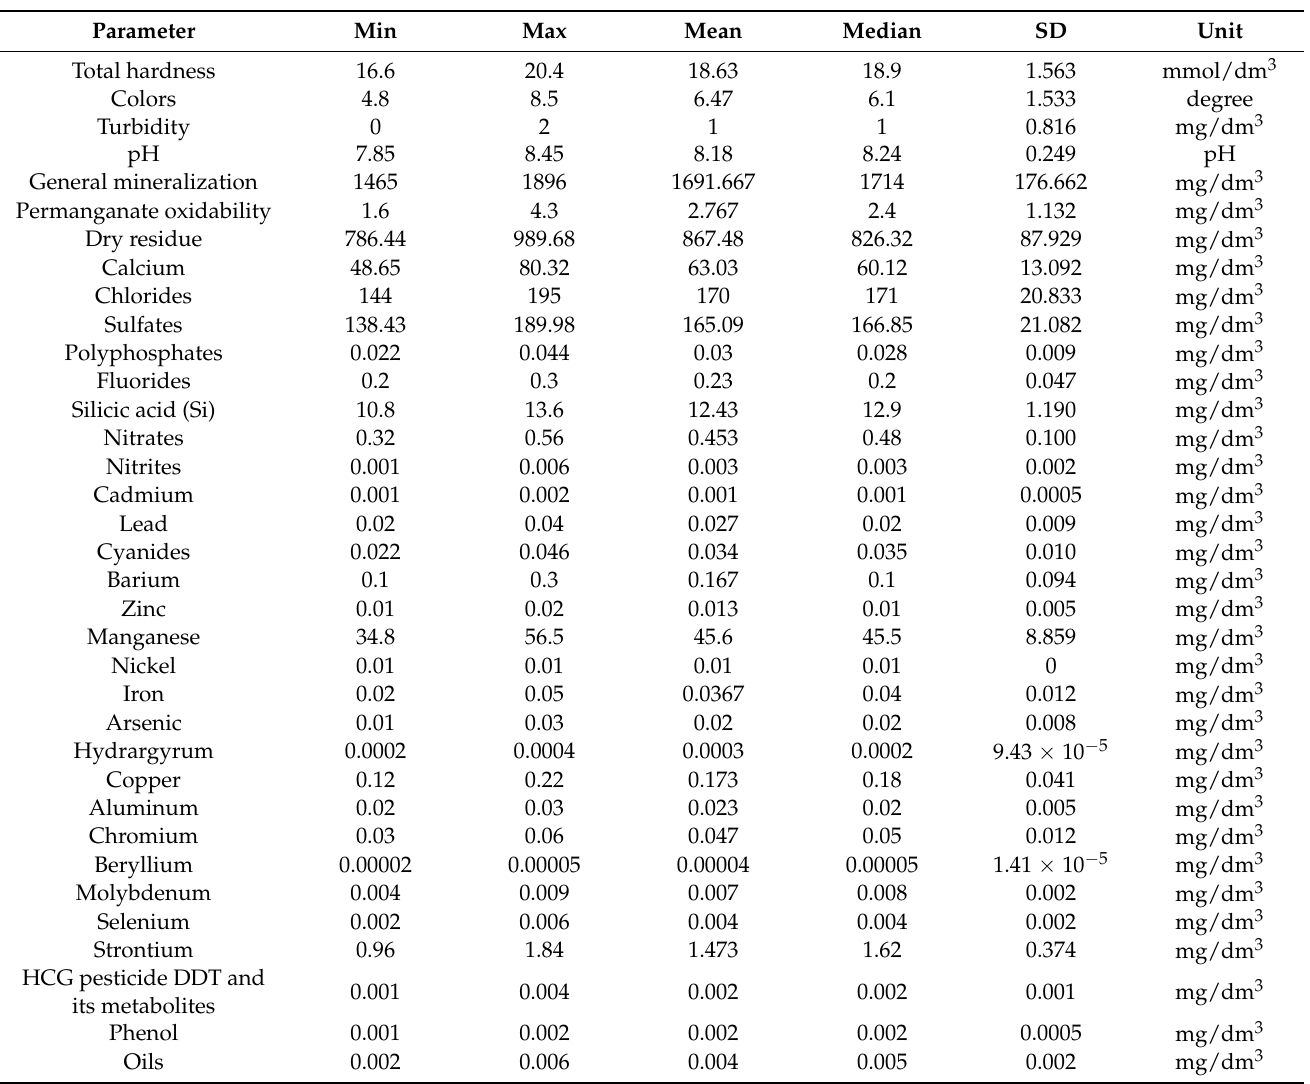
Table 5. Summary of the recorded concentrations in raw